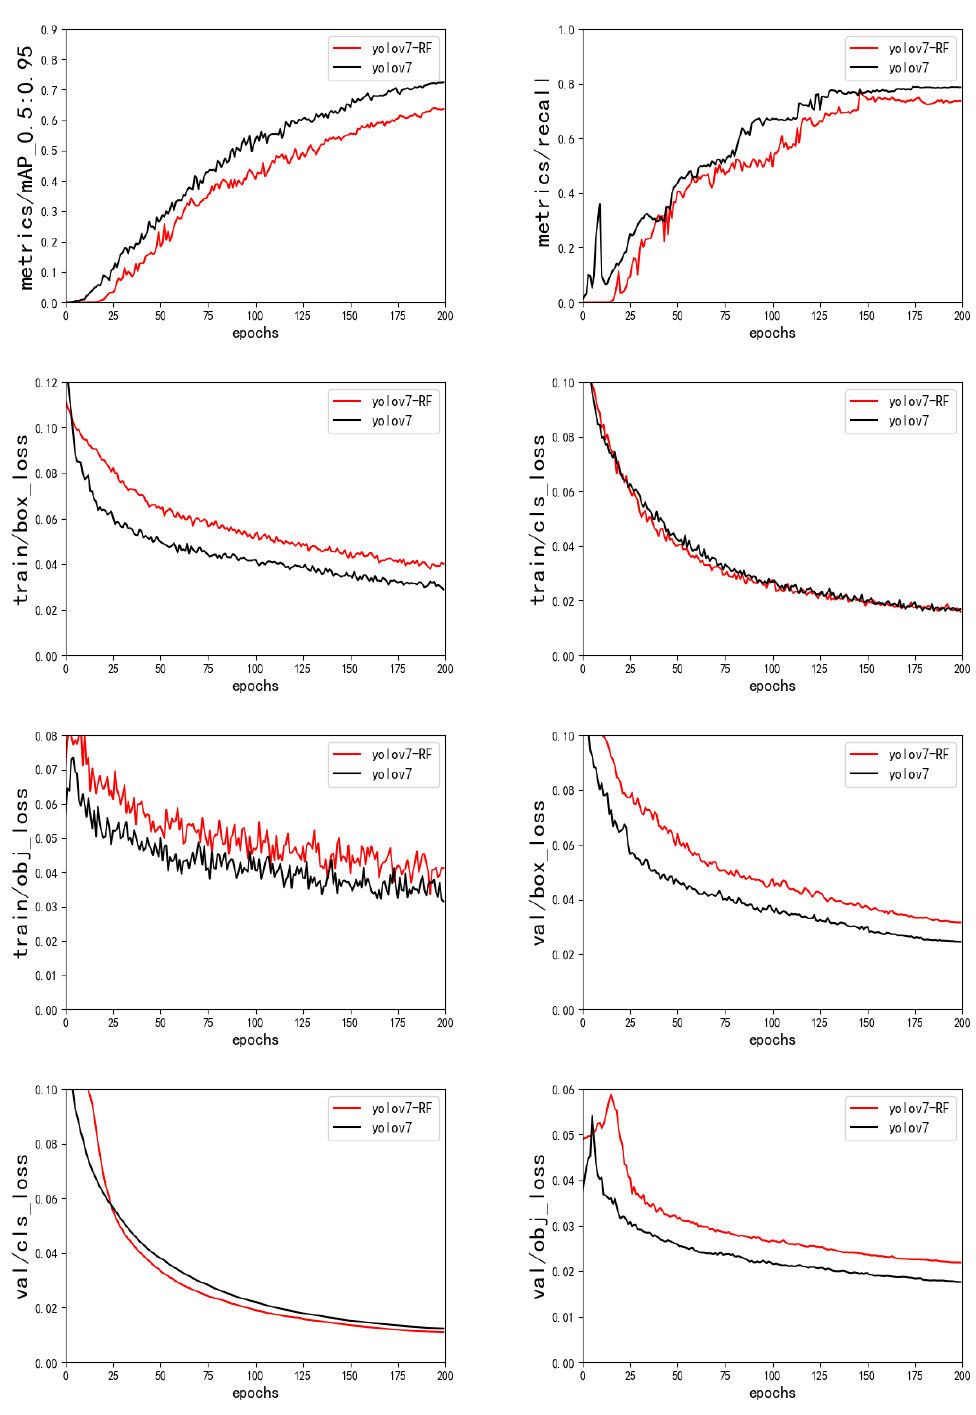
Figure 13. Results of the YOLOv7-RFLA ablation experiment. Table 5. YOLOv7-RFLA network performance.